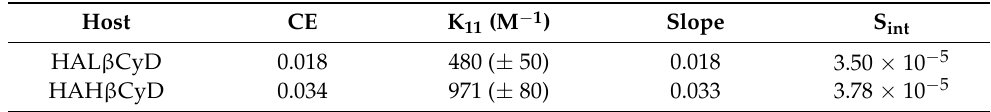
Table 1. CE and apparent stability constant (K) values for the inclusion of DOXO with HAH β CyD and HAL β CyD (25 ◦ C, Phosphate buffer, pH